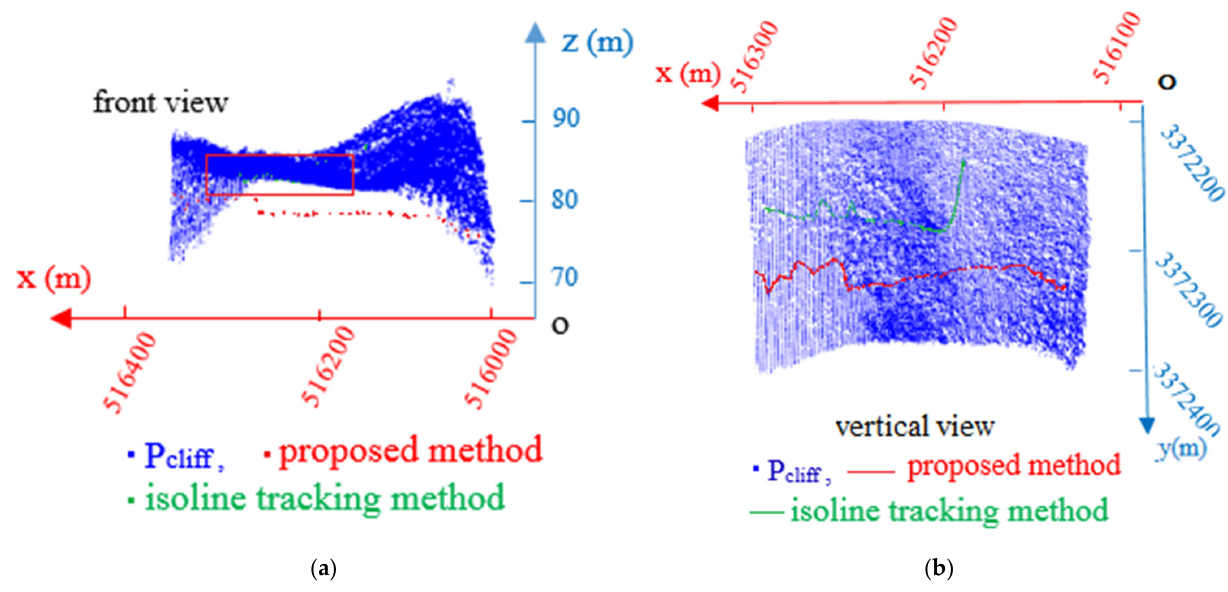
According to error theory, when the true value is unknown and there are multiple groups of observations, the average value of each group of observations can be regarded as its approximate true value. Therefore, assuming that the coastlines generated by the proposed method and the isoline tracking method are correct, the position of the average coastline can be calculated from these two groups of observations. Specifically, the two coastlines are converted to the same elevation plane; that is, they are in the same plane, and only the accuracy of their x- and y-coordinates is assessed. For the adjacent straight lines perpendicular to the x-axis, the difference in x values was fixed and small, which was set to 0.05 m in this case. These lines perpendicular to the x-axis intersect both shorelines, and the y-coordinate of the intersection can be inversely calculated according to the straight line composed of two points before and after the intersection. The y coordinate of the average shoreline is the average value of y coordinates calculated by the two types of shorelines, and the coordinate points of the average shoreline can then be calculated. Considering the points of the average coastline as the standard and passing a parallel line of the y-axis through the x coordinate of each point, the parallel line intersects the coastline extracted by Figure 15. The superposition of this method and isoline tracking method. the proposed method and the isoline tracking method. The accuracy of the two methods was estimated according to the accuracy estimation method [5], which is to calculate the The superimposed display of the coastline point clouds calculated using the pro ‐ x, y standard deviation and variance of the whole coastline by calculating the difference posed method and the isoline tracking method and the point cloud of the cliff segment between each point and the average value; the data is shown in Table 1. Error range refers are presented in Figure 16a. Points in the red box, that is, green points, were calculated with the isoline ‐ tracking method. In the figure, the green points will be projected into the to the interval segment of the y coordinate error value, and error range (points) refers to water surface, so the red and green points are approximately in the same plane, and their the number of points where the y coordinate error value is in this error interval. It can be elevations are close. Figure 16b shows the superposed display of coastlines generated seen from the table that the variance and standard deviation of the shoreline extracted by based on the two types of points and point clouds of the cliff section. The green coastline this method are 0.1528 and 0.0233, and the variance and standard deviation of the isoline shows a large error and a large deviation from the actual trend, whereas the red coastline tracking method are 0.3638 and 0.1338. Therefore, the shoreline extracted by this method is smoother, continuous, and closer to reality. has less error and higher accuracy.